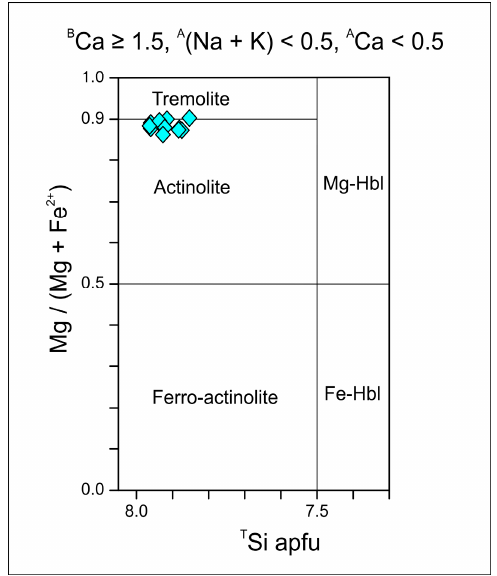
Figure 3. Simplified classification diagram [29] showing the amphibole composition determined by EPMA (12 spot analyses). Hbl indicates hornblende.